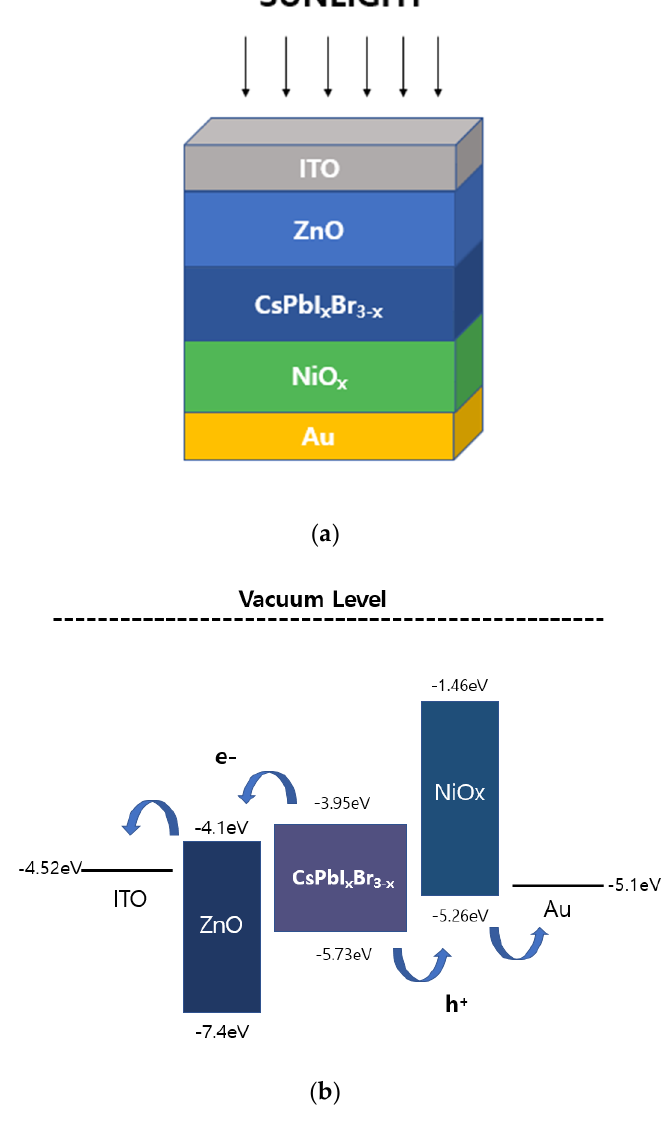
Figure 1. ( a ) The basic structure of an all-inorganic multi-layer perovskite solar cell (PSC). ( b ) The energy band alignment of an all-inorganic perovskite solar cell (PSC).